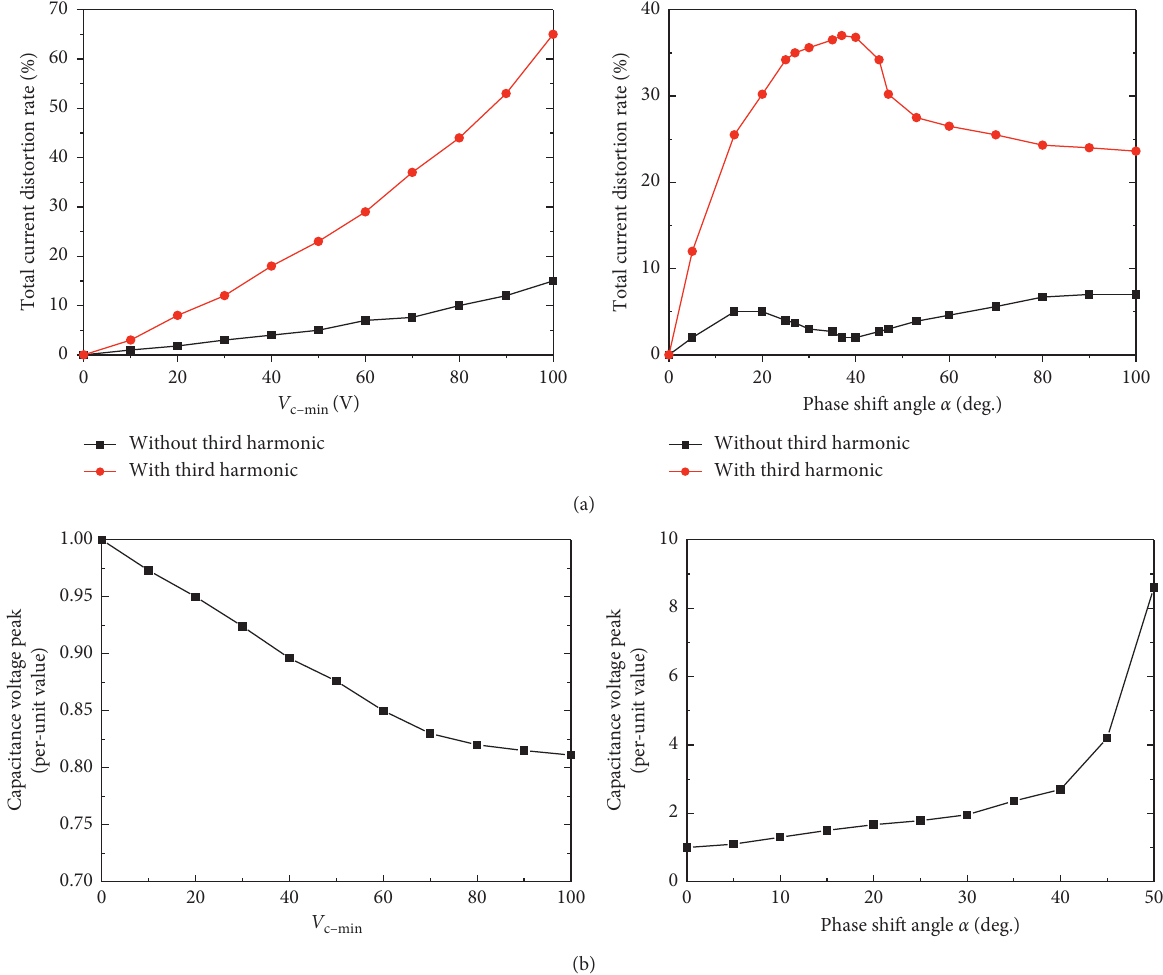
Figure 9: Reactive power parameter variation. (a) Current distortion rate change. (b) Change in capacitance voltage